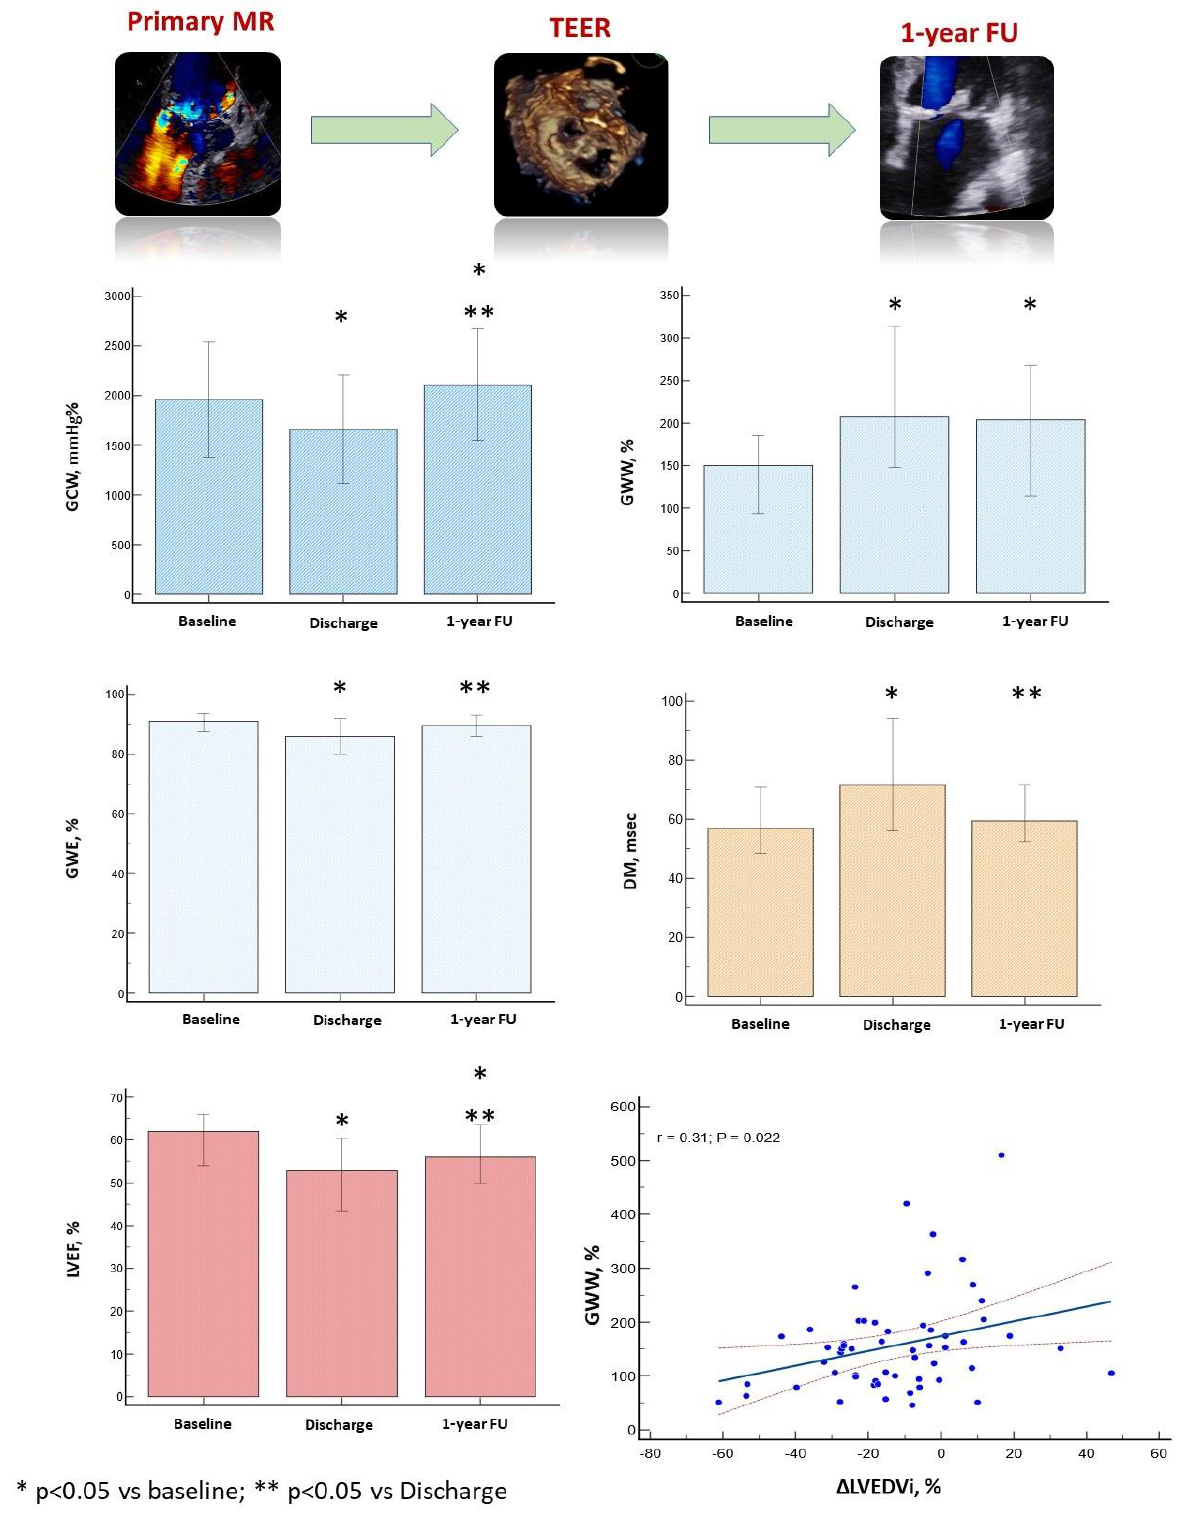
Figure 3. Variation of global constructive work, global work efficiency, global wasted work, left ventricular ejection fraction and mechanical dispersion from baseline to 1-year follow-up. Interestingly, baseline global wasted work was significantly associated with the left ventricular reverse remodelling at 1-year follow-up. Negative variation of the left ventricular end-diastolic volume corresponds to positive left ventricular reverse remodelling. Despite the significant variation of myo- cardial work parameters during the three-time points of the study, we observe a wide overlap of the standard deviation of these parameters and a significant dispersion of points at the linear